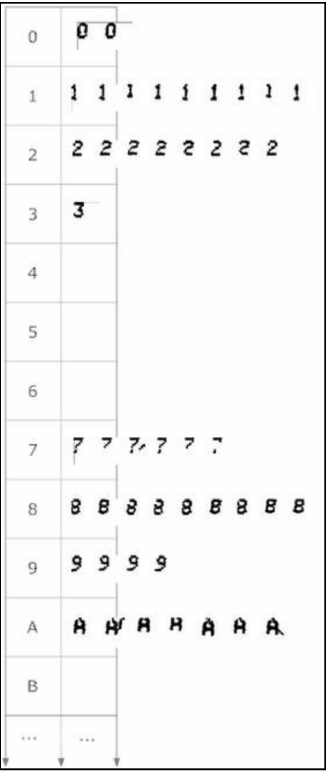
Figure 9. Partial view of the morphological family database. Some characters lack a morphological family because no examples occurred during